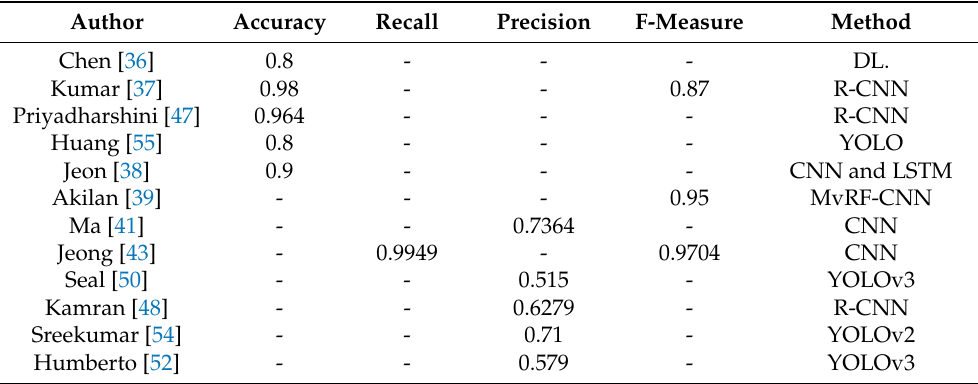
Table 2. Performance evaluation and characteristics of representative methods based on deep learning. Let ‘-’ indicate that the data was not